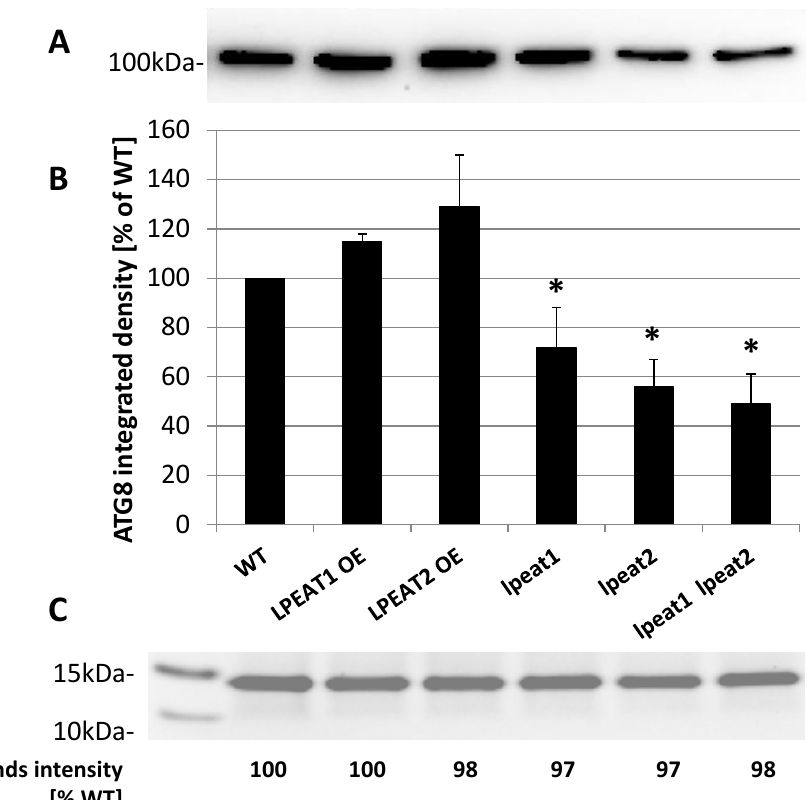
Figure 7. ( A ) AGT8-selected western blot analysis of the total protein extracts from leaves (0 DAF) of wild-type Arabidopsis plants (Col-0) and LPEAT1 and LPEAT2 overexpressors, lpeat1 and lpeat2 single mutants and lpeat1 lpeat2 double mutant grown in soil under standard conditions. The blot was incubated with polyclonal antibodies (anti-APG8a/ATG8a (abcam)) against AtATG8 protein. Equal amounts of protein (10 µg) were loaded and separated on NuPAGE 4 – 12% Bis-Tris-Gel. ( B ) ATG8 band average intensity (means ± SD) from 4 to 5 independent experiments as a percentage of WT. Asterisk indicates significant difference compared with LPEAT1 OE in “mean difference two sided test” at α = 0.05. ( C ) Fragment of selected gel with stained protein bands localized between 15 and 10 kDa and “Image Lab 6.01” analyses of the intensity of these bonds.